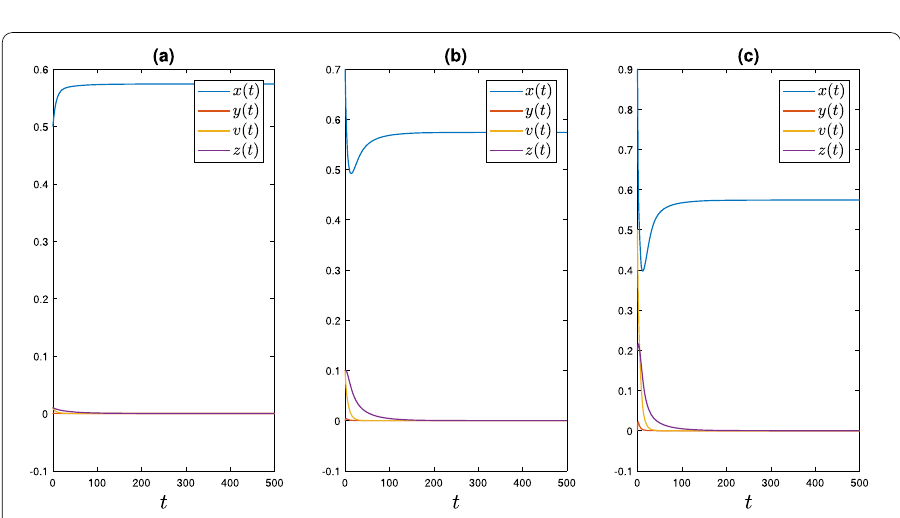
Figure 3 Numerical simulations of model (2) showing the time variation in the size of all relative populations of the model with various initial values. For these simulations, we used the following parameter values: r 1 = 0.3, a = 0.1, h 1 = 0.36, d 1 = 0.1278, c = 0.48, b = 2, h 2 = 0.16, e = 0.2, m 1 = 0.6, m 2 = 0.29, and n =